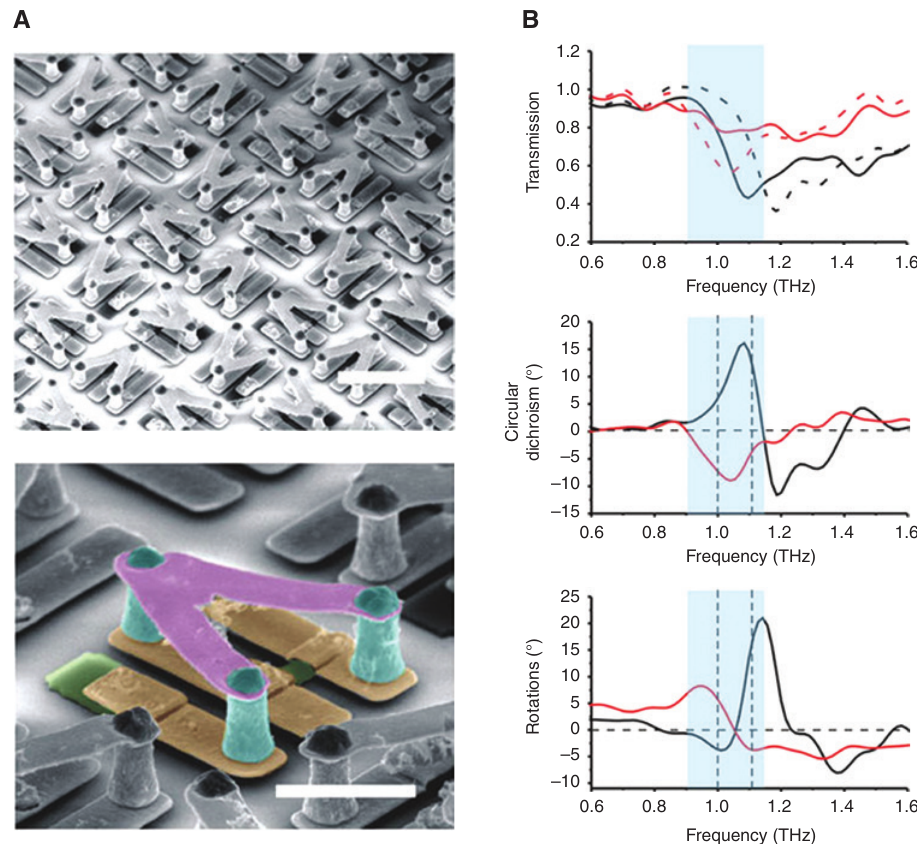
Figure 12: (A) SEM images of the fabricated chiral metamaterial. The scale bar is 25 and 10 μ m for the top and bottom panels, respectively. The purple, blue, and yellow colours represent the gold structures at different layers, and the two silicon pads are shown in green. (B) The top panel shows the measured transmission spectra of left-handed (solid) and right-handed (dashed) circular polarizations, without (black) and with (red) photoexcitation.The middle panel shows the ellipticity, and the bottom panel the polarization rotation angle arising from the transmission-phase difference without (black) and with (red) photoexcitation. Figure reprinted and adapted with permission from Macmillan Publishers Ltd.: Nature Communications [83]. ©